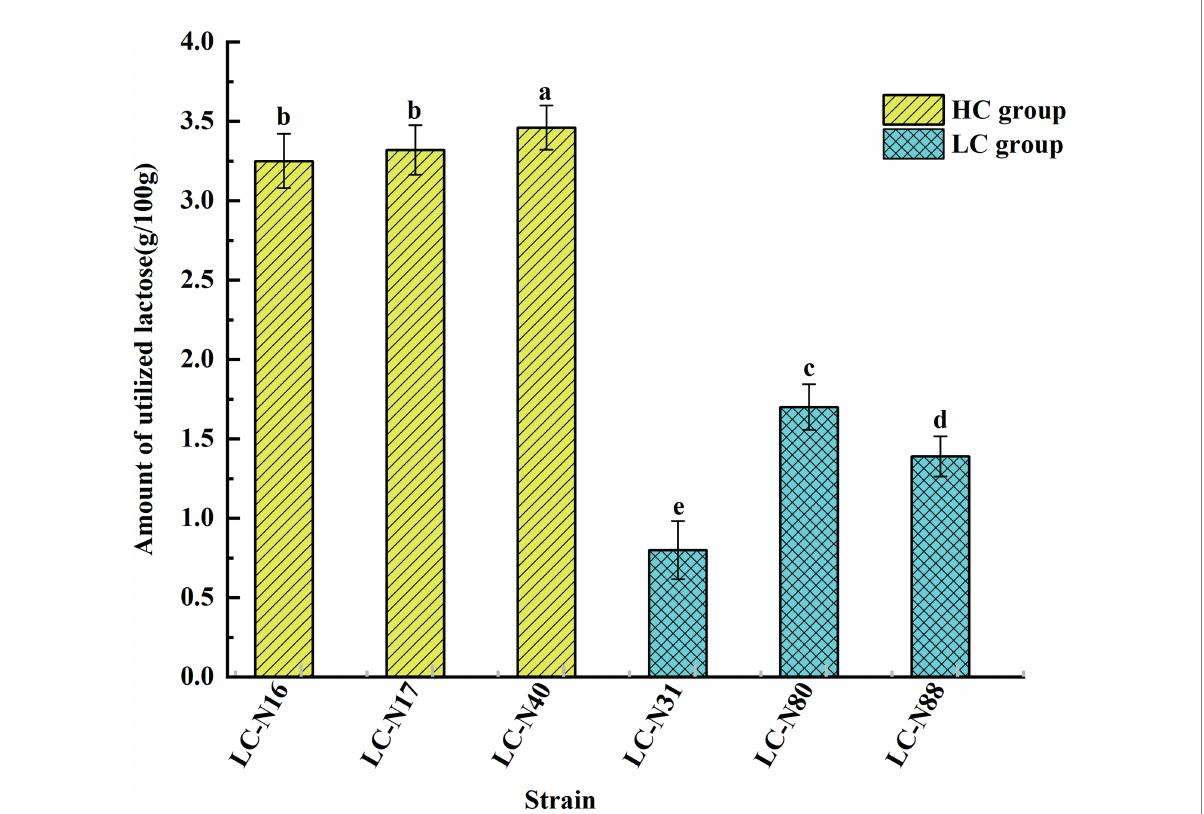
FIGURE 4 Lactose utilization by the six exemplar HC and LC strains. Relative amounts of lactose utilized by the exemplar HC and LC strains. The analyses were performed in triplicate and the results expressed as mean ± SD. abcde Different superscript letters indicate significant differences ( p <